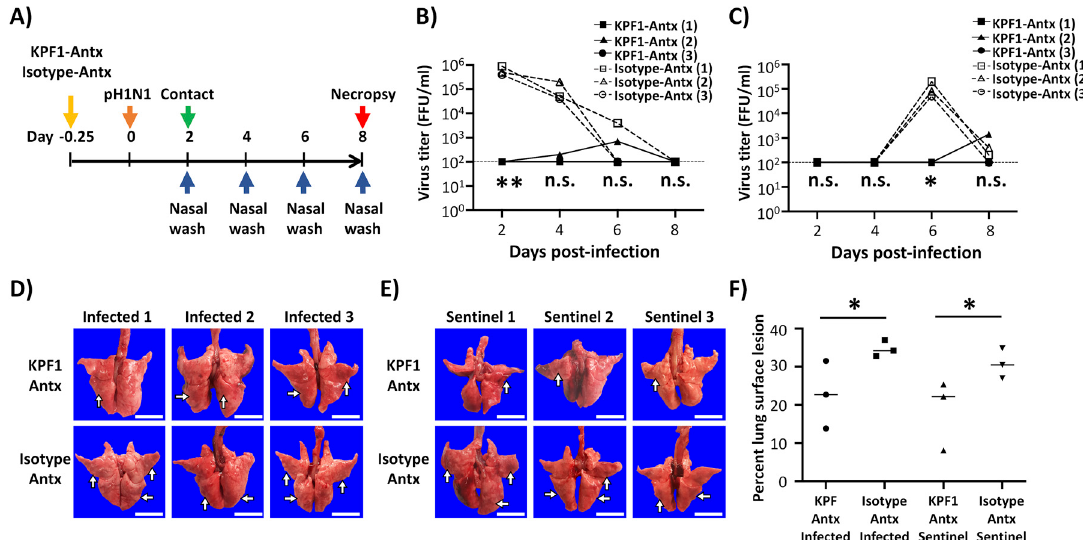
Figure 4. Prophylactic activity of KPF1-Antx hMAb in guinea pigs against pH1N1. ( A ) Schematic representation of the experimental approach: Female Hartley guinea pigs ( n = 3) were treated (i.p.) with 20 mg / kg of KPF1-Antx hMAb, or with 20 mg / kg of an IgG isotype control (isotype-Antx). Six h post-treatment, guinea pigs were infected (i.n.) with 10 3 PFU of pH1N1 and monitored daily for 8 days. At 2 d p.i., sentinel guinea pigs were introduced into the same cage of infected guinea pigs, allowing direct contact between the animals. ( B,C ) Viral titers from nasal washes: Viral titers in the nasal washes of infected (B) and sentinel (C) guinea pigs were determined at 2, 4, 6, and 8 d p.i. by IFA (FFU / mL). The dotted line represents the limit of detection of the assay. * p < 0.05, ** p < 0.01, or no significance (n.s.). ( D , E ) Gross observation of lung pathology: All animals were euthanized at 8 d p.i. and lungs were collected from infected (D) or sentinel (E) guinea pigs to observe gross pathological changes such as congestion and atelectasis (arrows). Scale bars = 1 cm. ( F ) Macroscopic pathology scoring: Distributions of pathologic lesion such as consolidation, congestion, and atelectasis were measured using ImageJ and are represented as the percent of the total lung surface area (%). * p < 0.05, or no significance (n.s.).